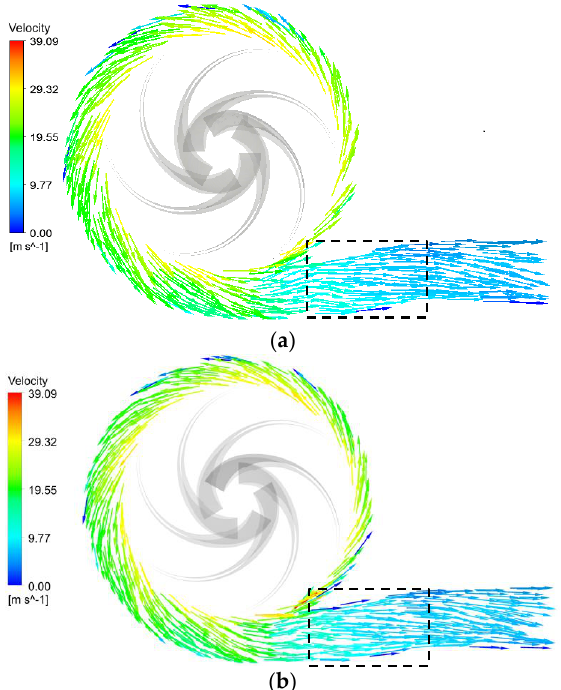
Figure 28. Velocity vector distribution on the middle section of the discharge chamber under Q 0.6 : ( a ) Impeller phase at 0°; ( b ) Impeller phase at 30°.